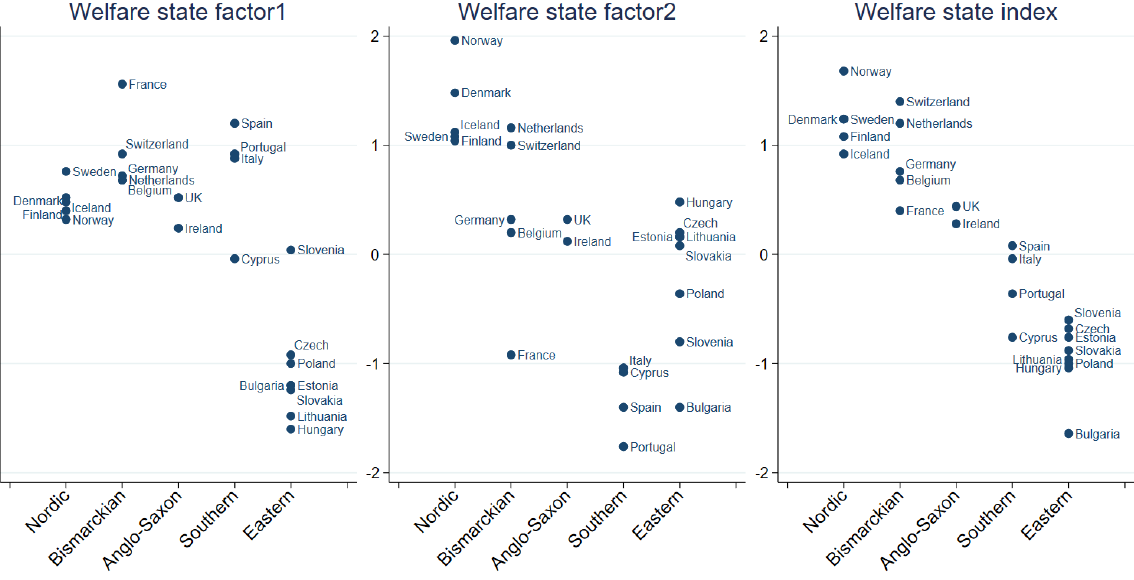
Figure 1. Country score on WS Factors and WS Index by WS regime type.